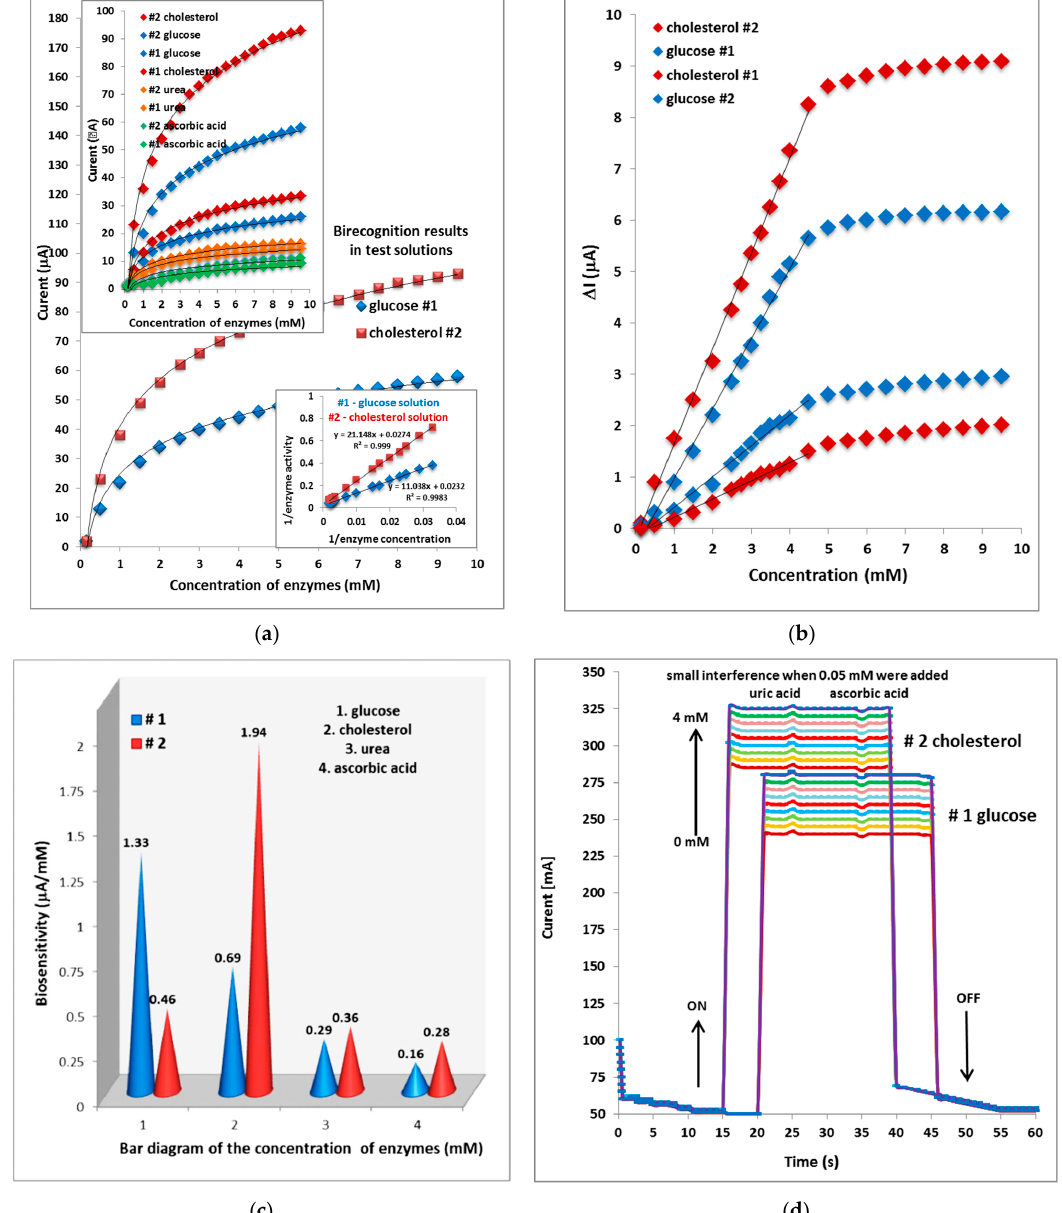
Figure 8. ( a ) Experimental results in test solutions: #1 and #2 samples; ( b ) calibration biorecognition samples with concentration of enzymes; ( c ) bar diagram of the concentration of enzymes in both samples; ( d ) current density response over time in the presence of increasing concentrations of en- zymes.